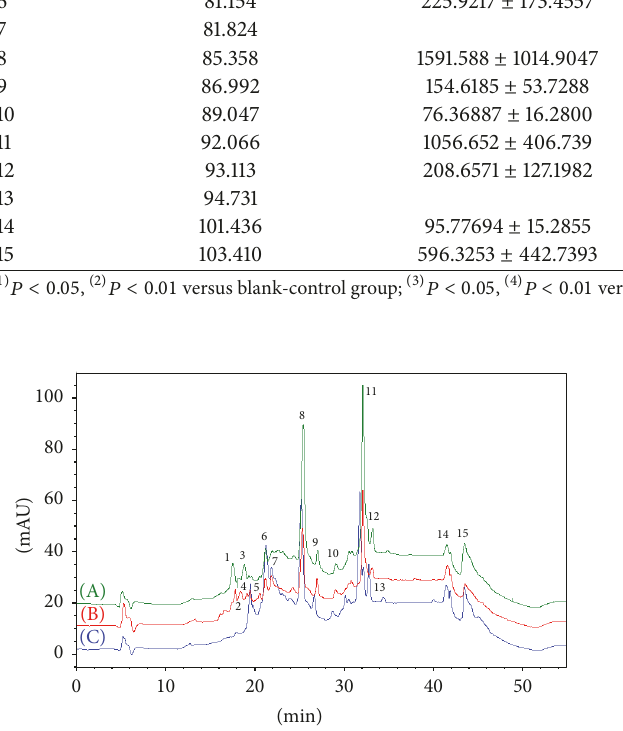
Figure 3: The peaks of peptides in the serum of restrained group.